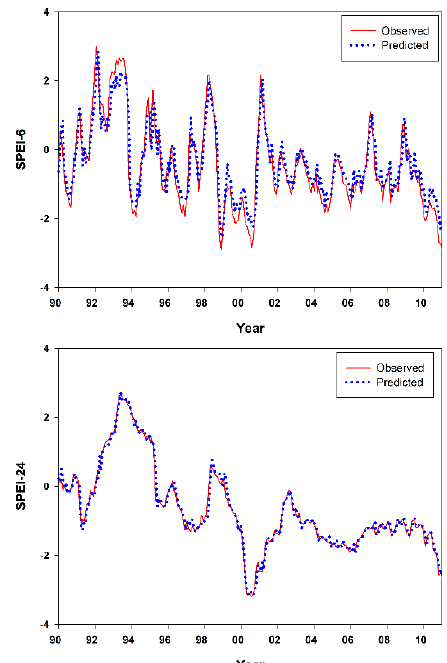
Figure 10. Observed and predicted standardized precipitation evapotranspiration index (SPEI) series over different time scales based on mean precipitation during 1990 to 2011 for Buraydah City.